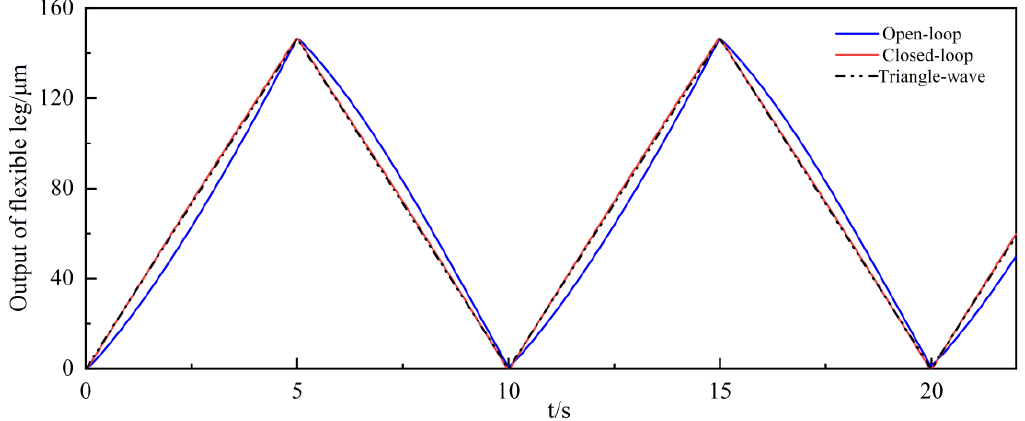
Figure 11. Hysteresis effect of the flexible leg with open-loop and closed-loop control.